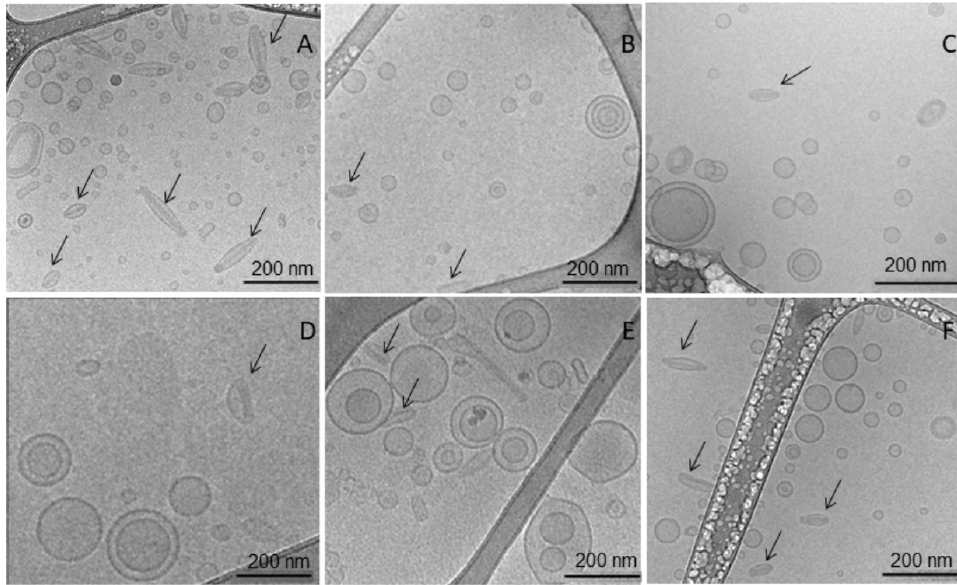
Table 6. Characterization of LCFL-PTX/DXR by Nanoparticle Tracking Analysis (NTA). Analysed Parameters Before Freeze-Drying